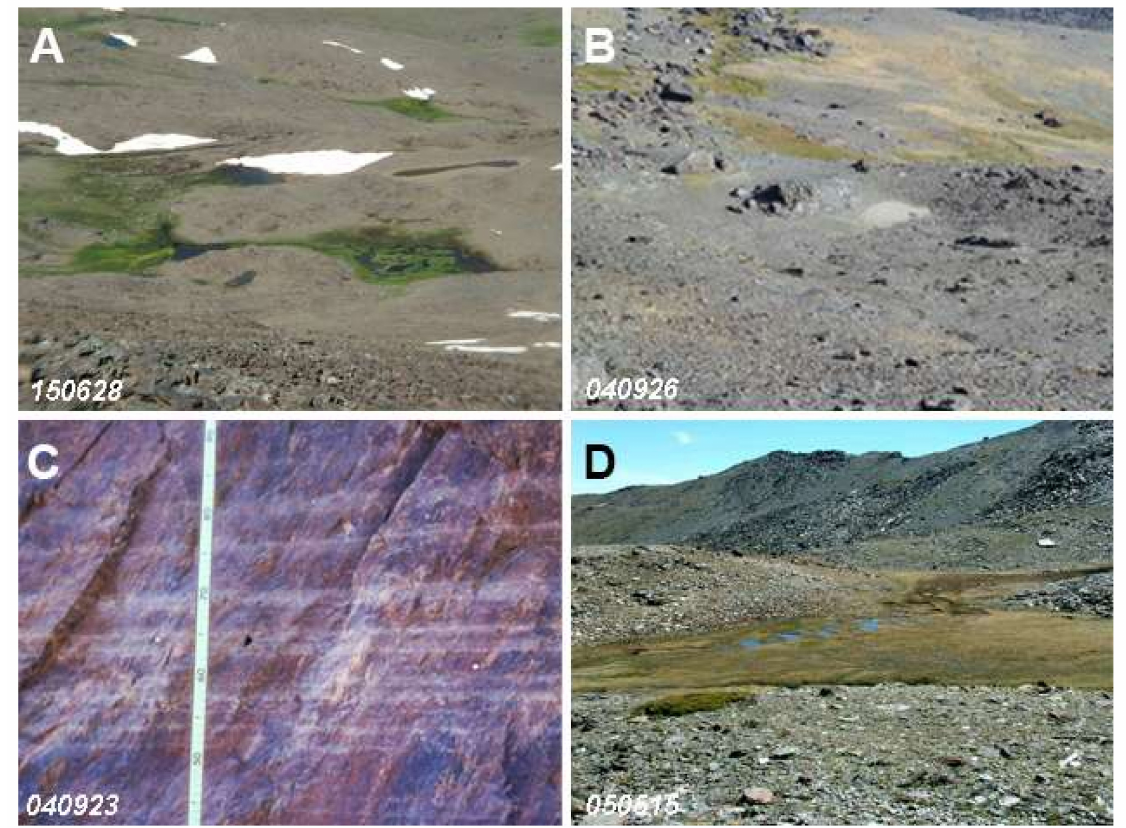
Figure 4. Some specific cases of ( A ) green fringes around Lagunas de la Virgen water-bodies, ( B ) sediments (whitish colour) deposited at the bottom of a small depression in the Guarn ó n River valley sporadically occupied by a water- body, ( C ) horizontal white bands of the maximum water level marked on a block on the edge of Laguna de Vacares and ( D ) “Stepped ponds” located in the Hoyo del Moro. The numbers in the lower left corner indicate the date of each photograph (year, month,